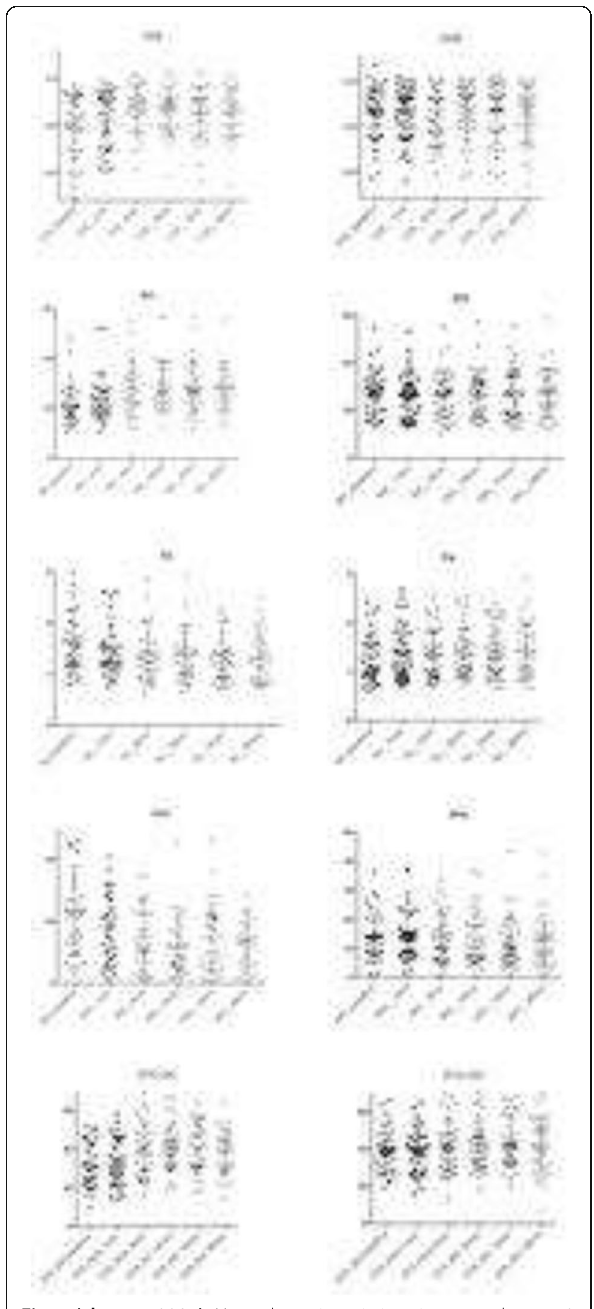
Fig. 1 (abstract 0094). Hemodynamic variations in responders at 10 and 30 minutes and non-responders